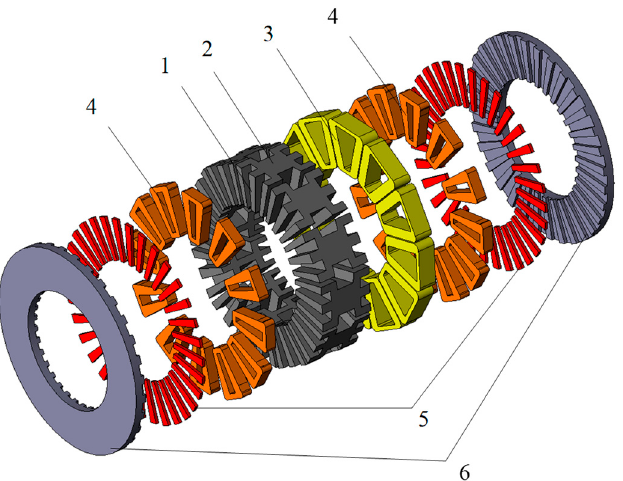
Figure 1. Exploded view of the proposed DR-HEAFPMVM. 1—Stator split-tooth, 2—stator main- tooth, 3—armature windings, 4—DC excitation windings, 5—PMs, and 6—rotor back iron.